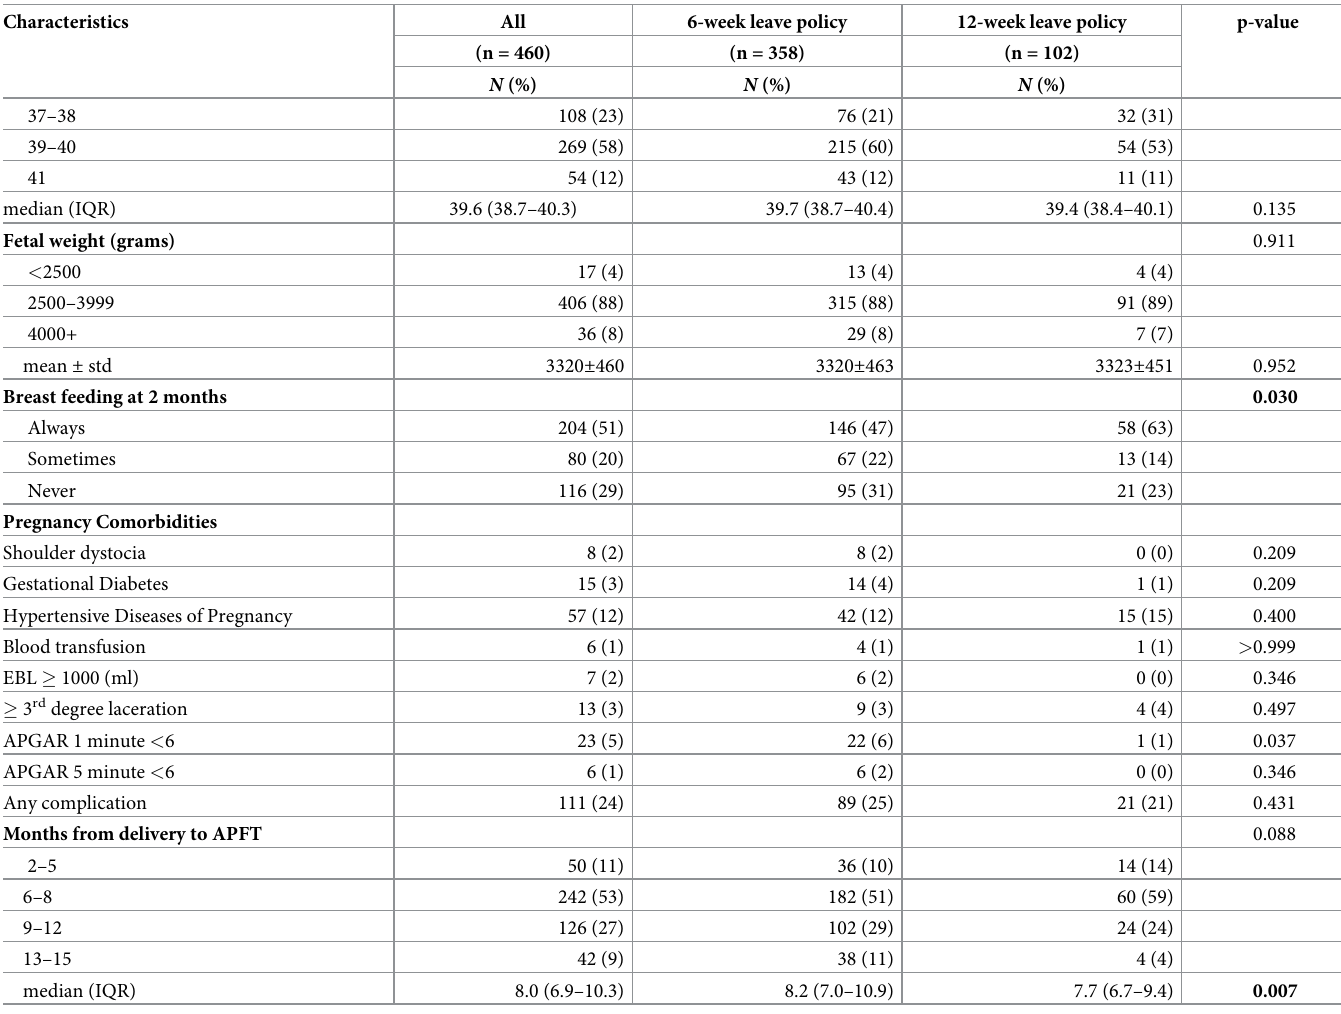
Mean APFT raw scores postpartum for each event and overall composite scores did not differ between leave groups (Table 2). Models adjusted for parity, age, BMI at new OB